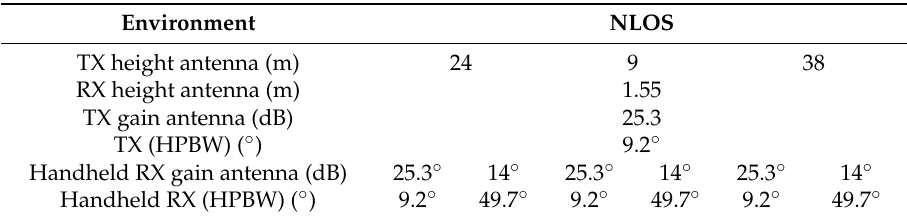
Table 2. Measurements between TX and RX with a frequency of 38 GHz.